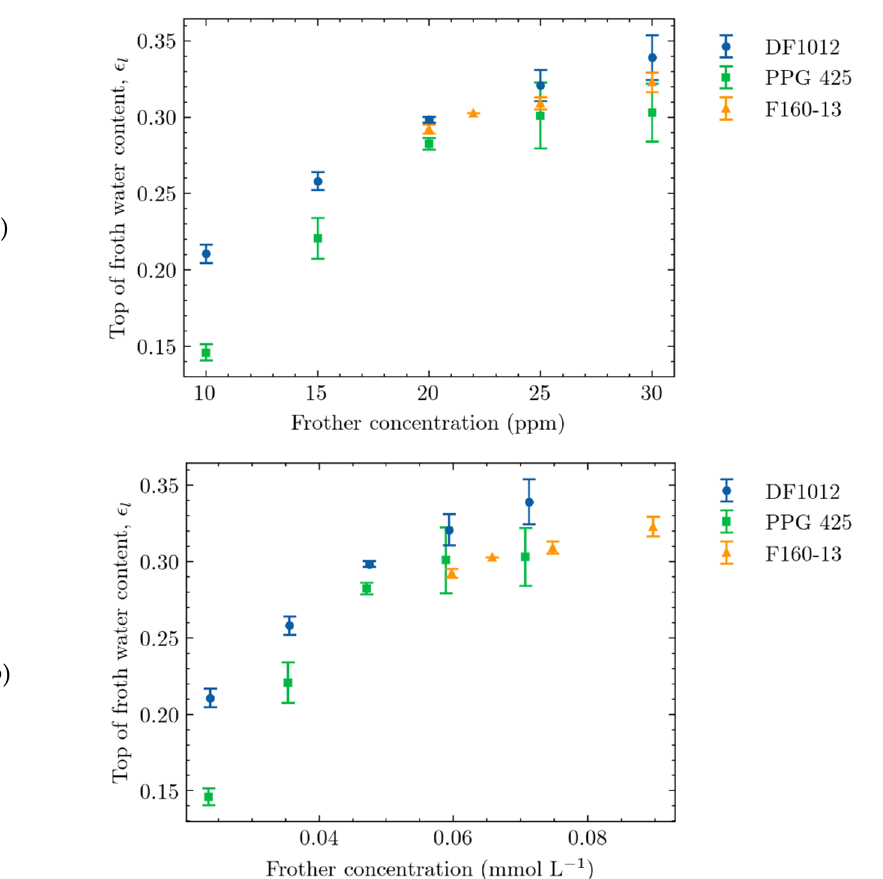
Figure 9. Effect of changing frother concentration ( a ) units of ppm and ( b ) units of mmol L − 1 on the top-of-froth water content at 1.8 cm s − 1 .